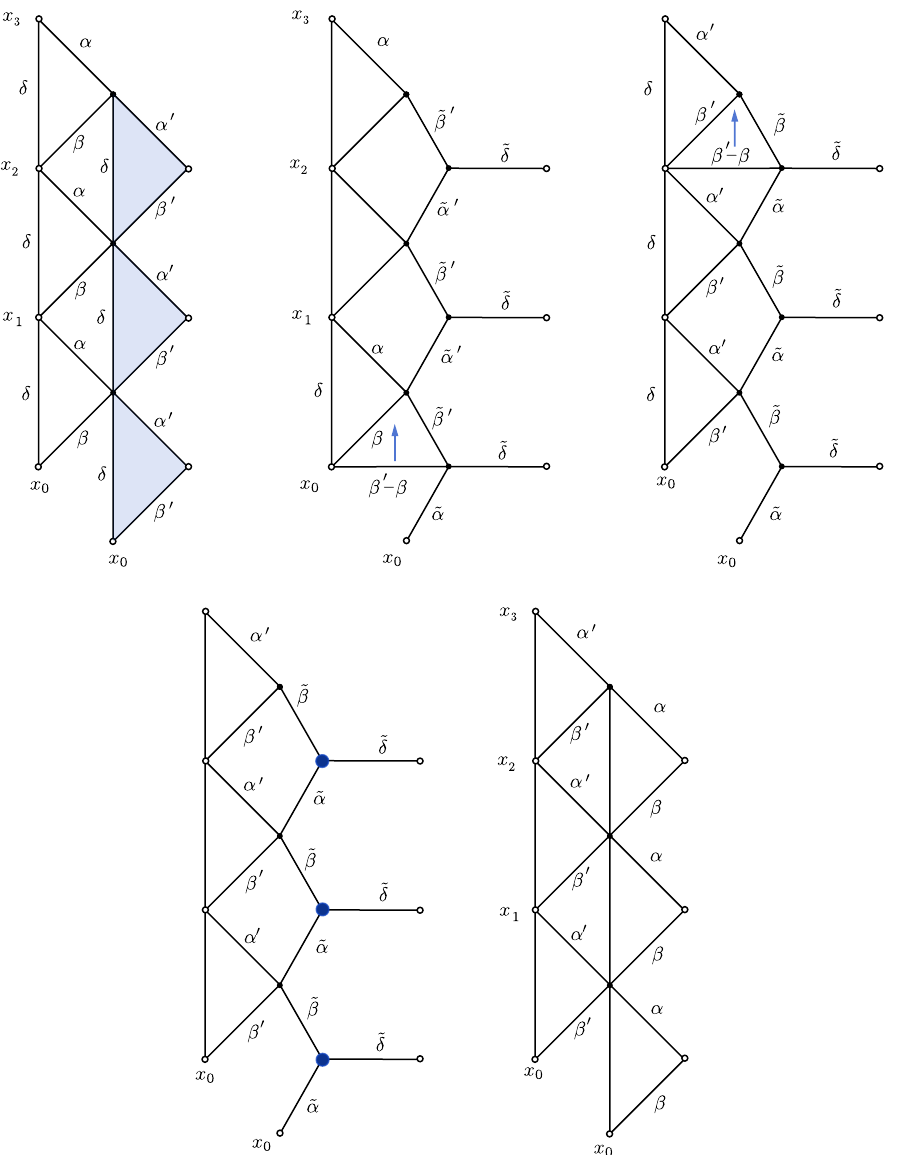
Figure 11 . Commutation of operators Q 3 computed at different values u 6 = u 0 of the spectral parameter. Up left: the blue triangles are replaced by star integrals. Up center: upwards movement of the horizontal line of power β − β 0 , by a chain of star-triangle identitites. Up right: the last passage involves star-triangle and chain-rule indentity. Down left: integration of the blue vertices by star-triangle identity. Down right: the final result is equal to the first picture with exchanged u and u 0 , i.e. ( α, β ) ↔ ( α 0 , β 0 )